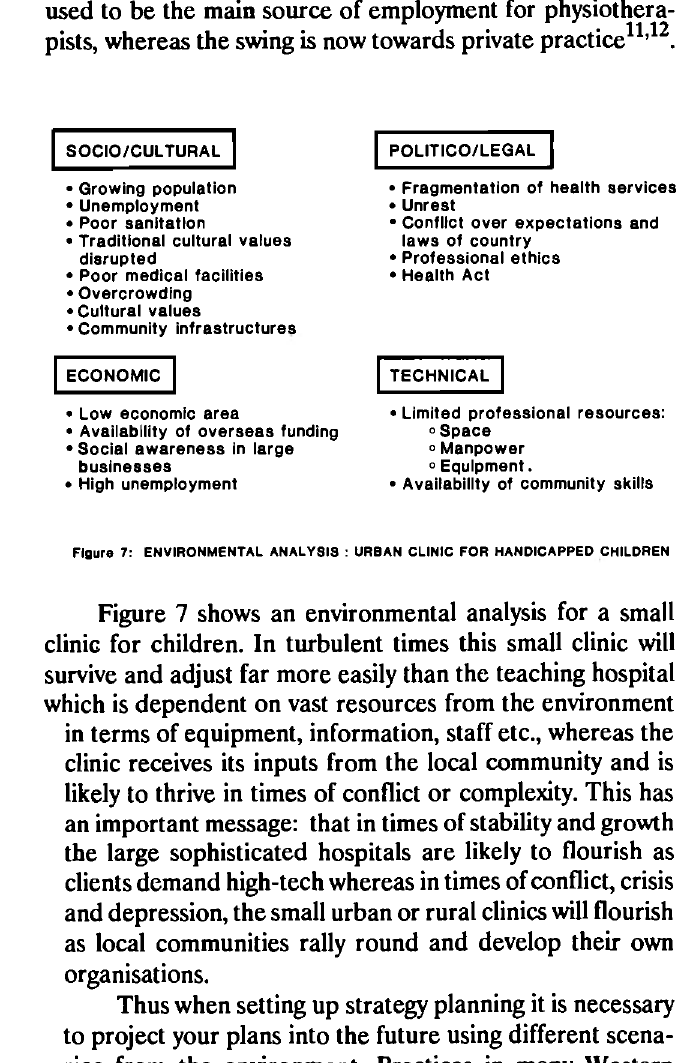
Figure 6: THE EXTERNAL ENVIRONMENT : ITS EFFECT ON